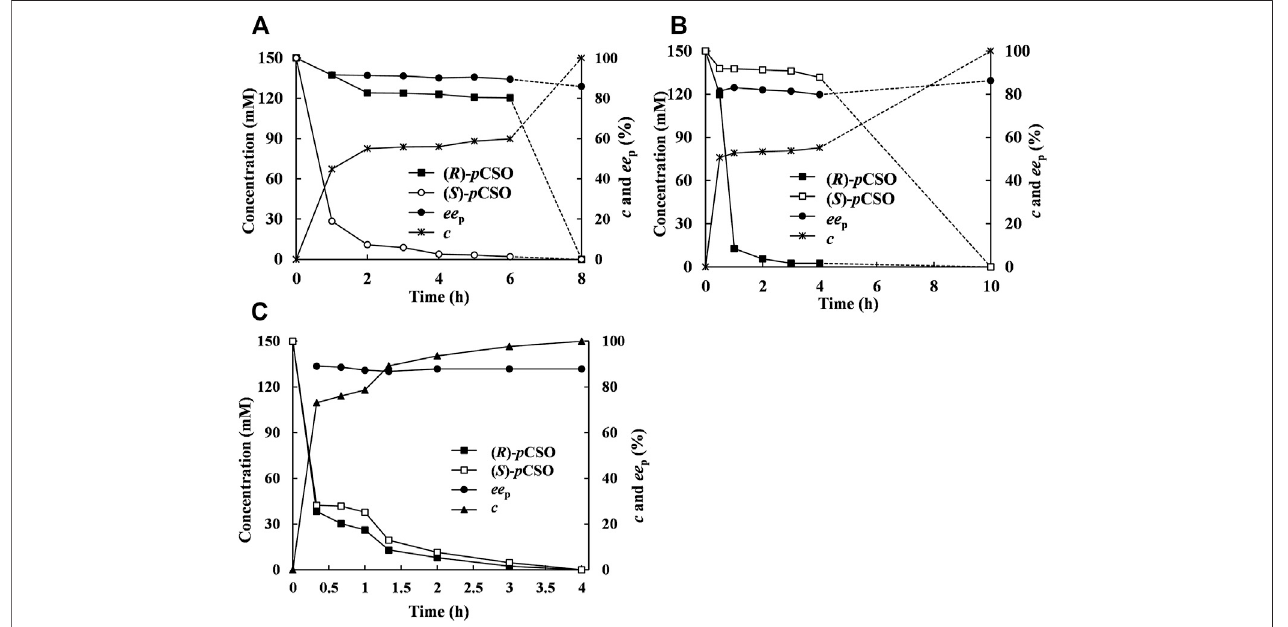
FIGURE 5 | The hydrolytic course curve of rac-p CSO catalyzed by E. coli / pveh 1 z4x4-59 and E. coli / rpeh F361V . (A) bi-enzymatic catalysis in a sequential addition mode. About 300 mM rac-p CSO was fi rst hydrolyzed by E. coli / pveh 1 z4x4-59 , and then E. coli / rpeh F361V was added to sequentially hydrolyze the residual ( R )- p CSO. (B) About 300 mM rac-p CSO was fi rst hydrolyzed by E. coli / rpeh F361V , and then E. coli / pveh 1 z4x4-59 was added to sequentially hydrolyze the residual ( S )- p CSO. (C) Bi-enzymatic catalysis in a simultaneous addition mode. About 300 mM rac-p CSO was hydrolyzed by adding both E. coli / rpeh F361V and E. coli / pveh 1 z4x4-59 simultaneously. The enantioconvergent hydrolysis of rac-p CSO was in the 4% (v/v) Tween-20/phosphate buffer system (100 mM, pH 7.0) at 25 °